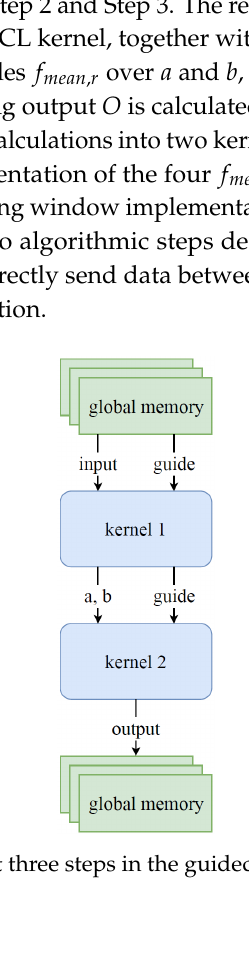
Figure 6. Stream of image data.